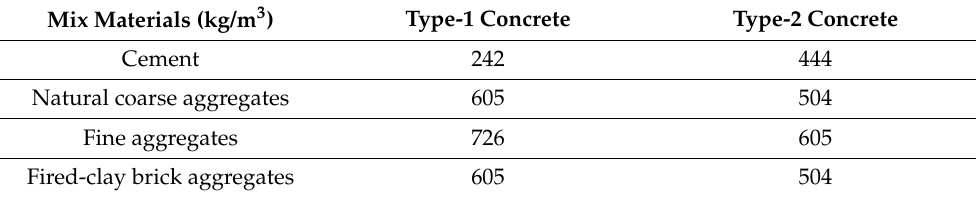
Table 2. Concrete design mix.